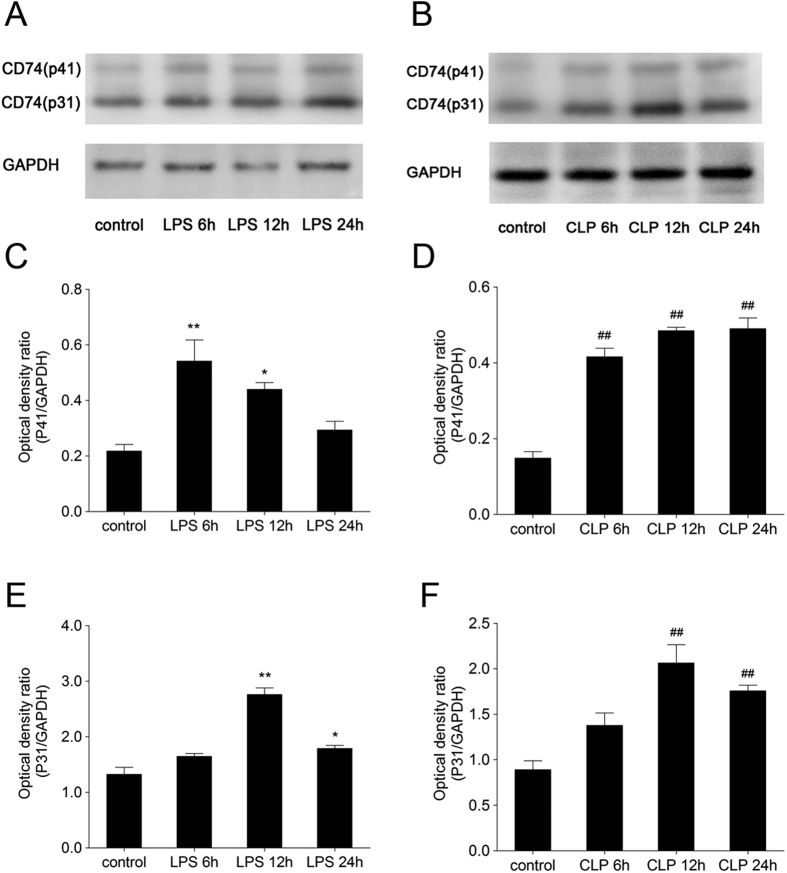
Western blot and densitometry analysis of CD74 protein in lungs.Immunoblotting using 30 μg lung proteins revealed marked up-regulation of CD74 at certain time post injury in lungs from lipopolysaccharide and cecal ligation and puncture induced acute lung injury models compared to control. Two bands of 31 and 41 kDa corresponding to two different isoforms of CD74 (p31 and p41) are shown (A,B). The amount of p31 expression was much higher than p41. Relative protein levels were quantified by densitometry and expressed as optical density ratio (C–F) with GAPDH serving as internal standards. Immunoblotting data are representative of experiments performed in triplicate and statistical differences are noted (*p < 0.05, **, ##p < 0.01 compared to control with Dunnett-t test after ANOVA for multiple comparisons).